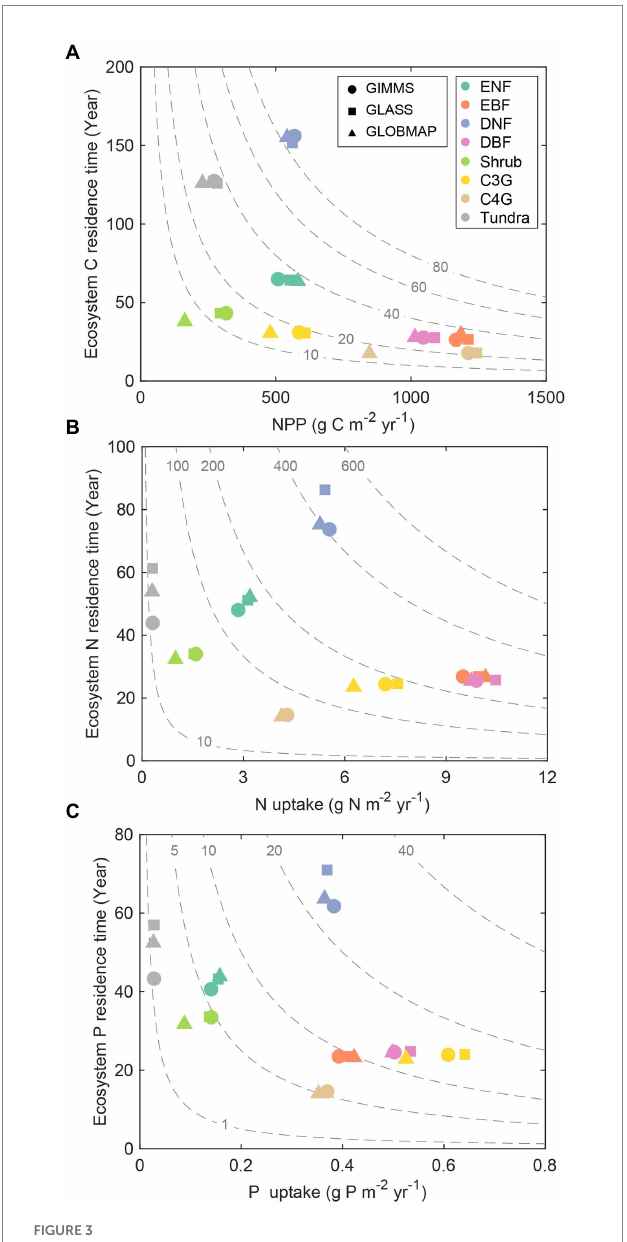
FIGURE 3 Decomposition of ecosystem carbon (A) , nitrogen (B) , and phosphorus (C) storage into its influx and ecosystem residence time in various biomes for each simulation. ENF, evergreen needleleaf forest; EBF, evergreen broadleaf forest; DNF, deciduous needleleaf forest; DBF, deciduous broadleaf forest; Shrub, shrub land; C3G, C 3 grassland; C4G, C 4